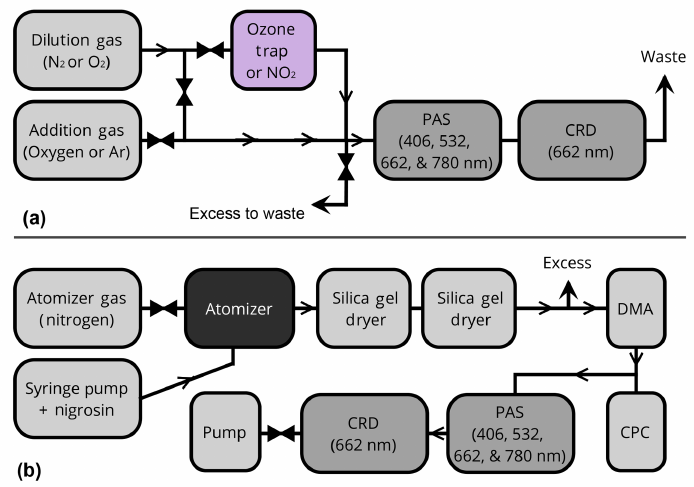
Figure 1. Block diagram of the experimental setup. (a) Setup used for O 3 and NO 2 measurements, and (b) setup used for nigrosin mea- surements. Triangles indicate mass flow controllers or critical orifices; arrows indicate direction of flow. CPC: condensation particle counter; DMA: differential mobility analyzer; CRD: cavity ring-down